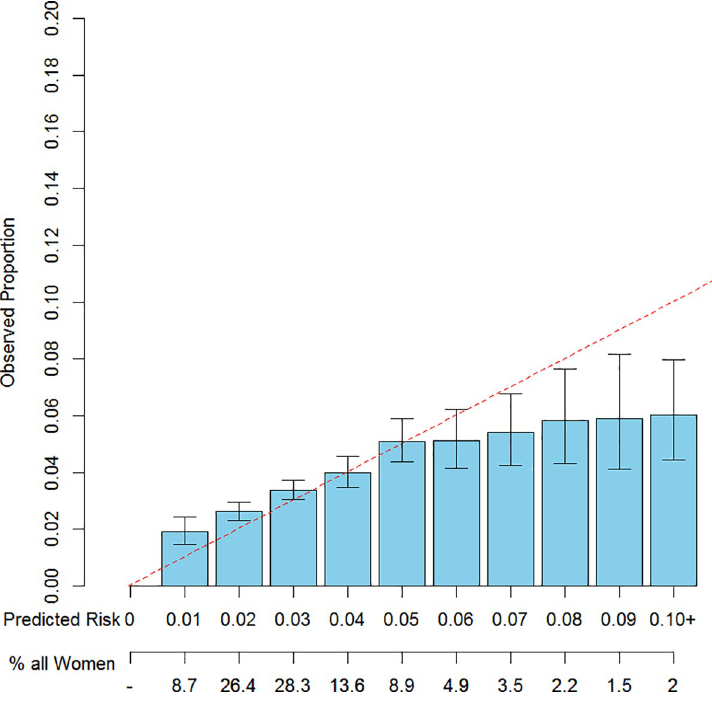
Fig 2. Observed vs. expected counts of 5-year absolute risks vs. 1% risk bins, of Gail Model predicted risks.